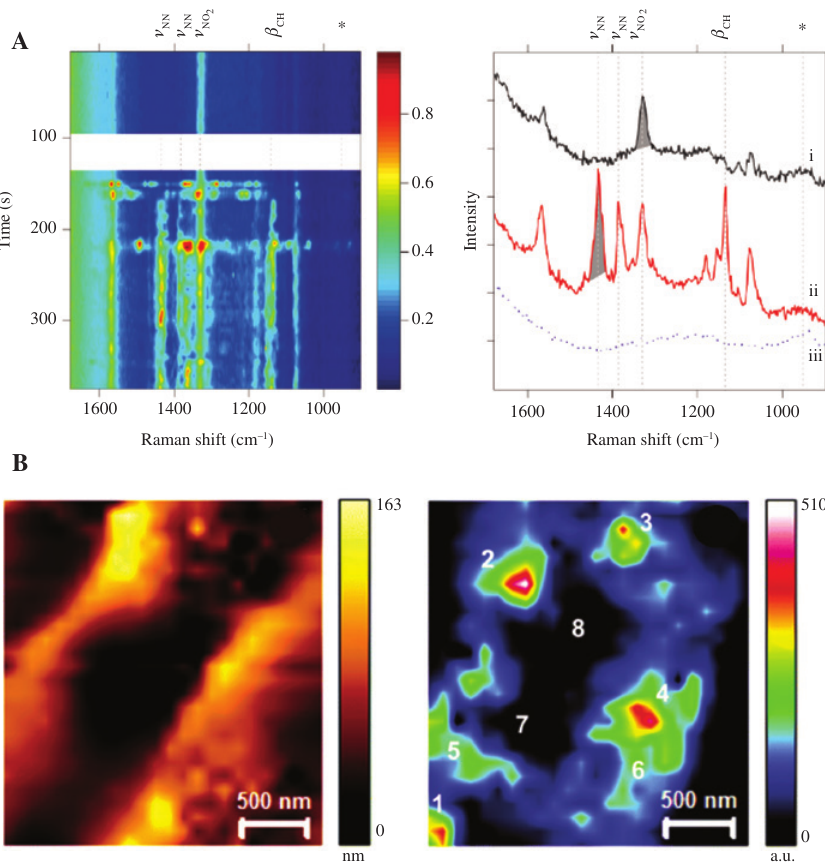
Figure 7: Plasmon-mediated photocatalytic reactions monitored with TERS. (A, left) Time-dependent TERS measurements before and after irradiation with 532 nm laser light. Raman signatures begin to appear in the TERS spectra after the tip is illuminated with a 532 nm excitation source. (A, right) Raman spectra corresponding to 4-NBT (black) and DMAB (red). (B) Topography image of the Ag substrate (left) and TERS chemical reactivity map of DMAB after inducing dimerization of pMA (right). (A) Reprinted with permission from Ref. [127]. Copyright 2012. (B) Reproduced from Ref. [129] with permission of The Royal Society of